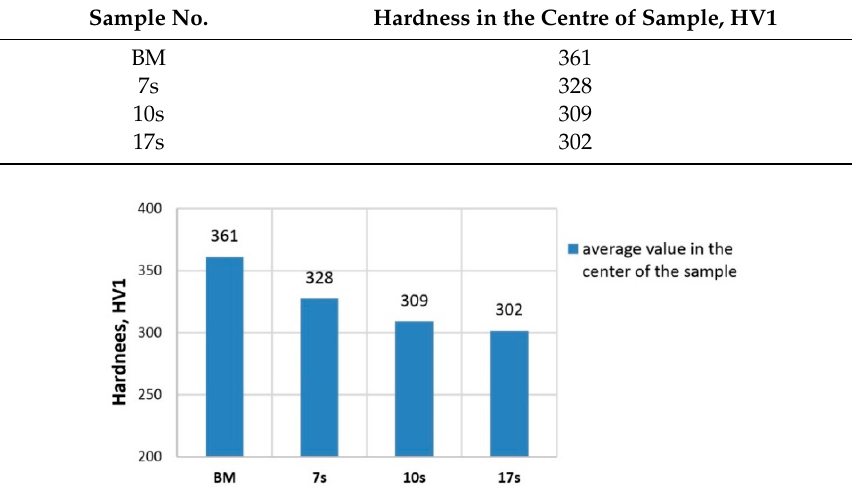
Figure 18. Hardness values of the base material and samples with different cooling times t 8/5 .